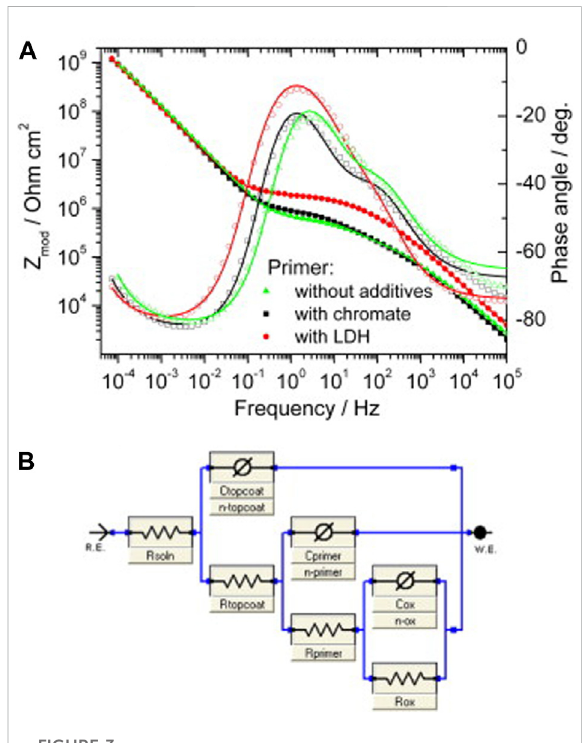
FIGURE 3 Bode plots (A) of AA2024 samples, coated with primer and top coat without additives, with chromate and with LDH-VO x , taken after 4 months of immersion in 0.5 M NaCl. Solid lines show the fi tting results according to model (B) . Reproduced from (Zheludkevich et al., 2010) with permission from